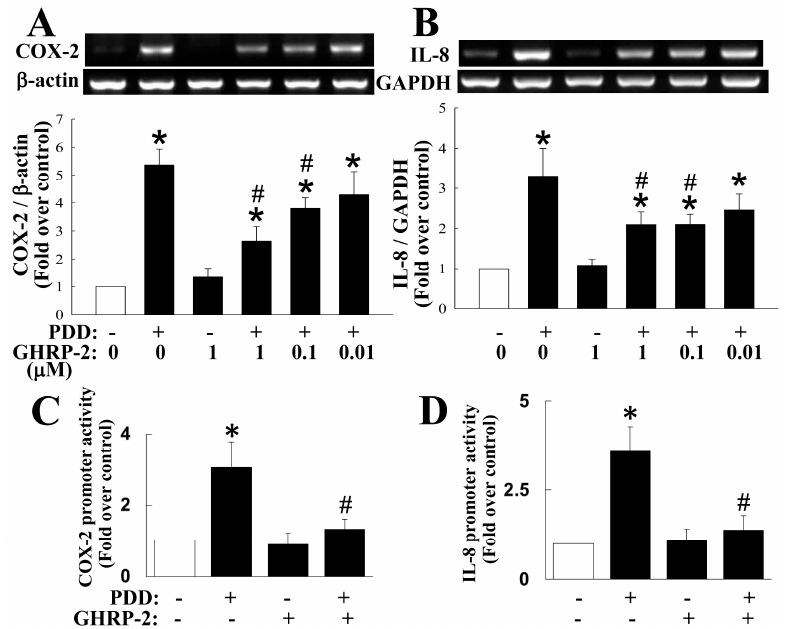
Figure 5. Attenuation of PKC-induced COX-2 and IL-8 transcription and mRNA expression by GHRP-2. Plated KGN cells were pretreated with GHRP-2 (0.01, 0.1, and 1 µM) for 2 h, and then PDD (100 nM) was included for an additional 12 h. The COX-2 ( A ) and IL-8 ( B ) mRNA expression levels were determined by RT-PCR. ( C , D ) To determine the promoter activity of COX-2 and IL-8 genes, plated KGN cells were transfected with a human COX-2 or a human IL-8 promoter construct, each with a luciferase reporter gene; these were co-transfected with pCMV- β -Gal as a control plasmid. The transfected cells were untreated, treated with either PDD (100 nM) or GHRP-2 (1 µM) alone or a combination of PDD and GHRP-2 for 12 h. Cells were then harvested with Glo lysis buffer and the COX-2 ( C ) or IL-8 ( D ) promoter activity was determined by luciferase assay; the luciferase activity was normalized against the β -galactosidase activity from pCMV- β -Gal within the same samples. The results represent the means ± SEM (( A , B ): n = 4; ( C , D ): n = 3). * p < 0.05 compared with the control; # p < 0.05 compared with the PDD treatment.